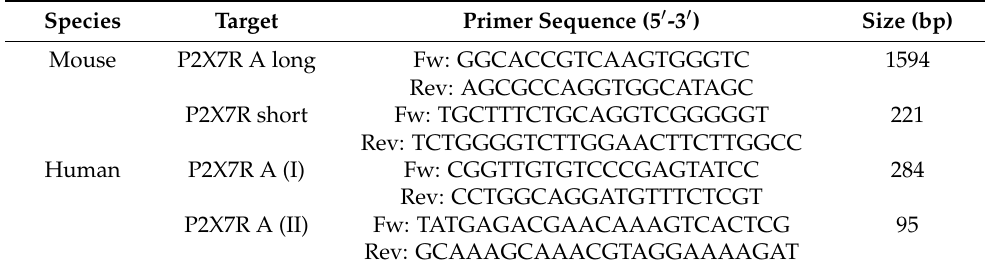
Table 1. RT-PCR primers used in this